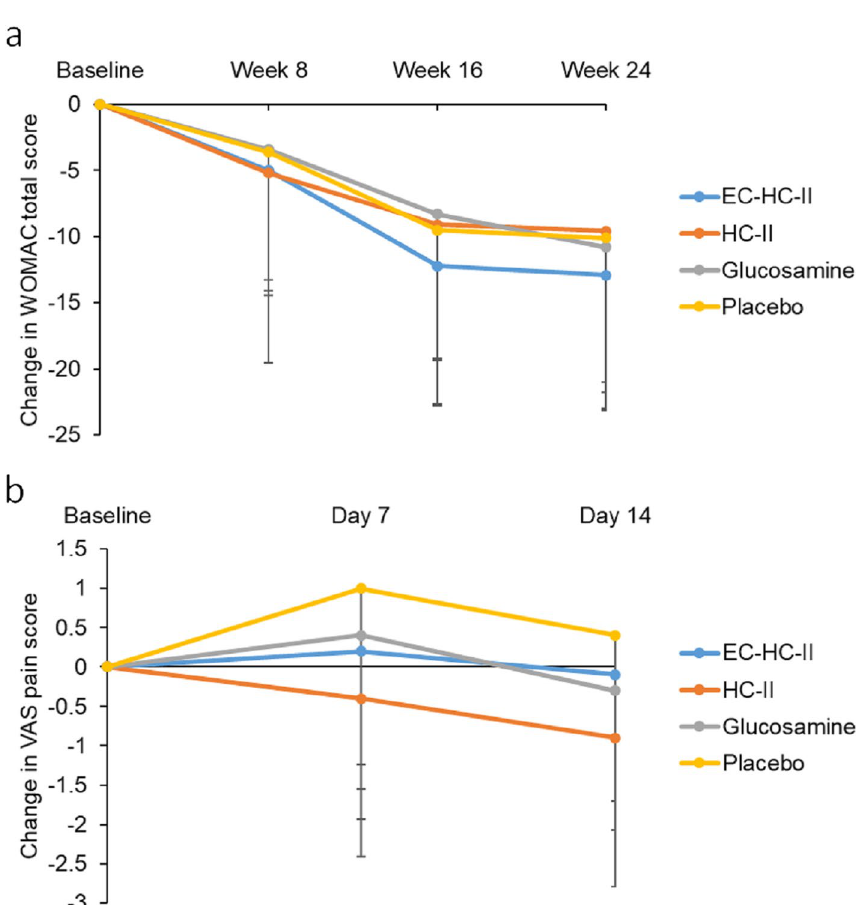
Fig. 2 Boxplot diagram describing E/e of NASH present group and absent